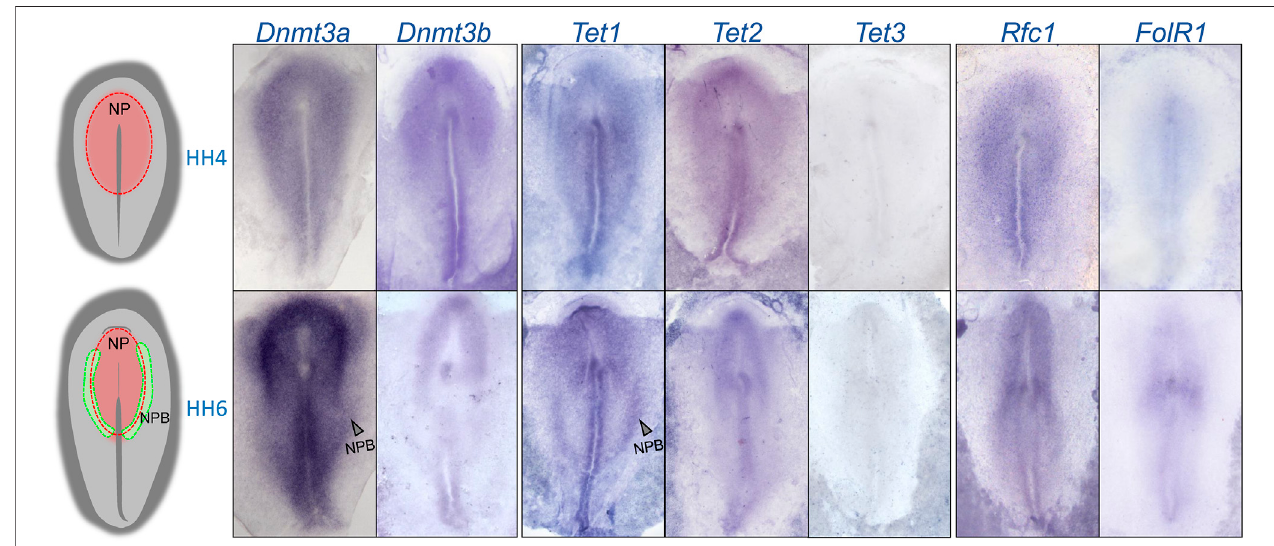
FIGURE1| Spatio-temporalexpressionof5mCand5 hm Cwritersandfolatetransporters.AroughschematicofaHH4andHH6embryosshowingtherespective positions of the neural plate (NP) and neural plate border (NPB). Whole mount in situ hybridization of Dnmt3a , Dnmt3b , Tet1 , Tet2 , Tet3 , FolR1 , and Rfc1 during gastrulation (HH4) and early neurulation